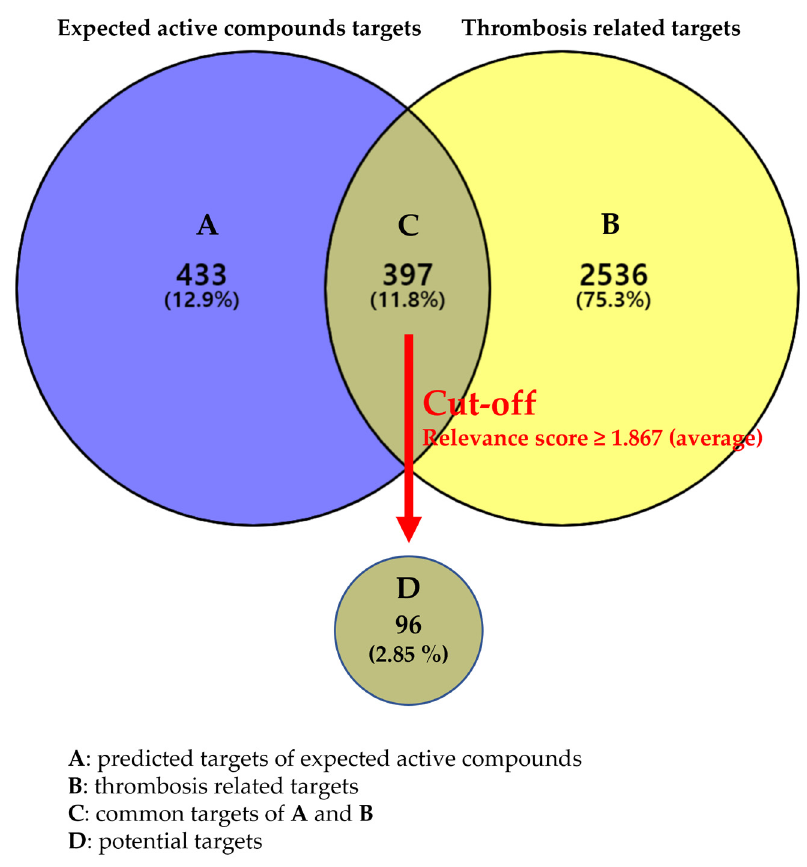
Figure 1. Venn diagram of EAC and disease-related targets.